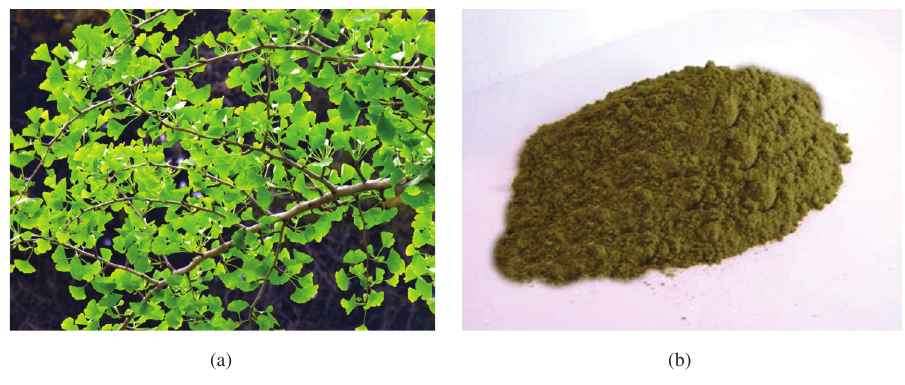
FIGURE 1: (a) Ginkgo biloba ; (b) leaves